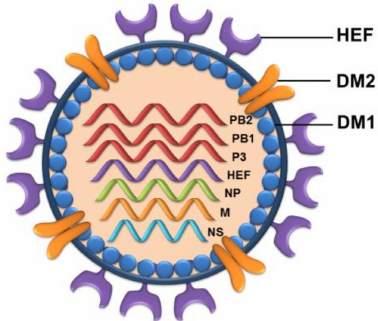
Figure 2. Schematic representation of influenza D virus. IDV is an enveloped virus with seven RNA segments. The virions are 80–120 nm in diameter. The glycoprotein hemagglutinin-esterase fusion (HEF) helps in viral entry into the host cells. The protein DM2 acts as the ion